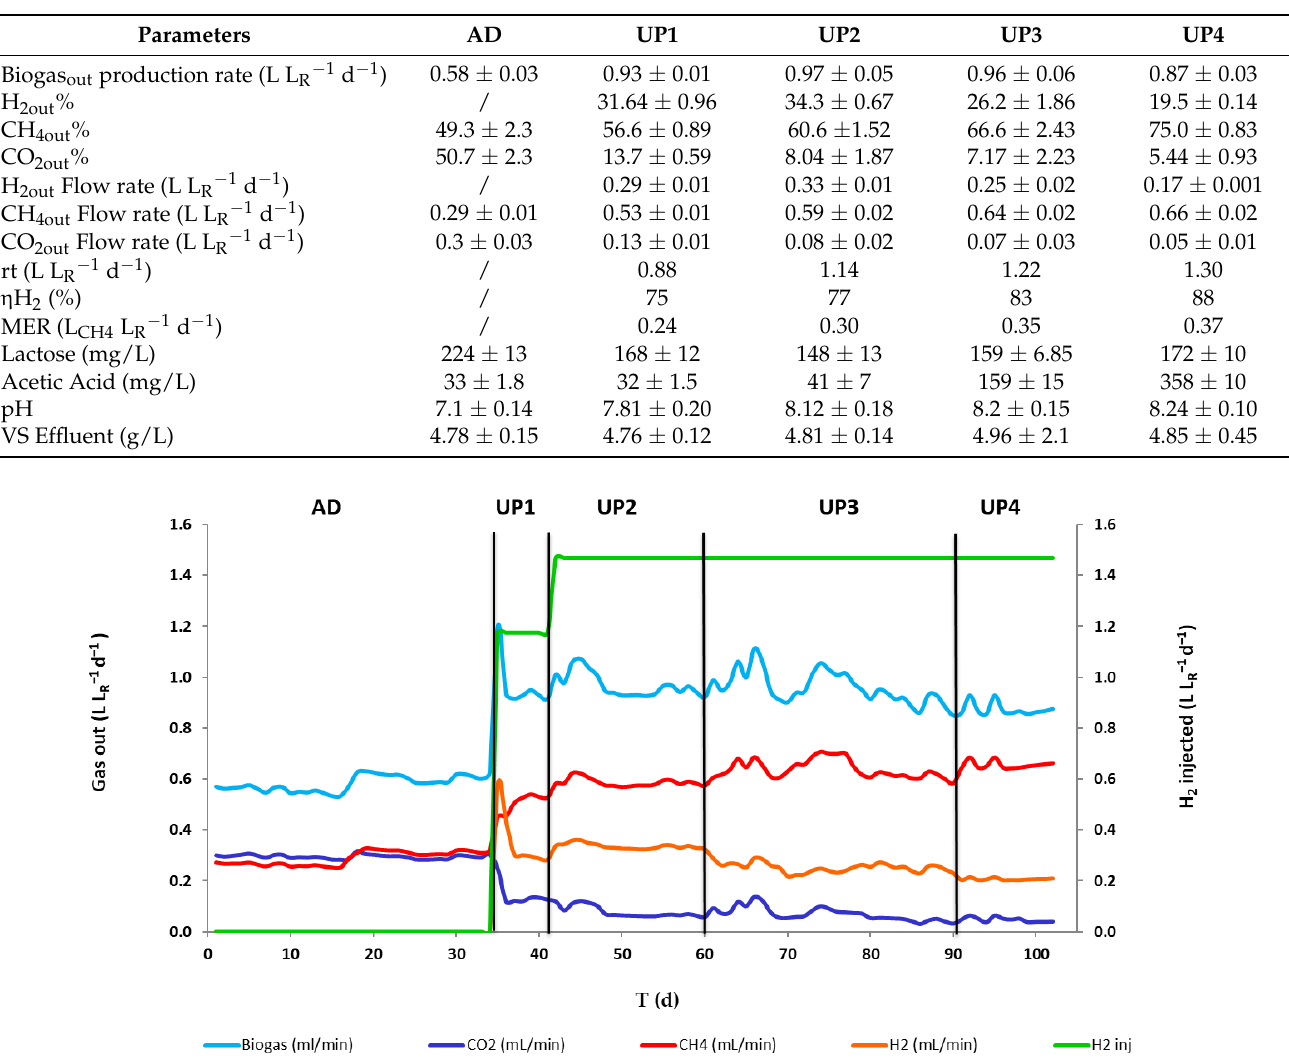
Figure 1. Daily time courses of biogas H 2 , CH 4 , CO 2 flow rates of all experimental phases. After 17 days of the AD period, a consistent rate of methane production was achieved, with an average of 0.29 ± 0.03 L CH4 L R − 1 d − 1 , Figure 1. The pH of the reactor remained stable at around 7.10 ± 0.14, indicating that the system had a strong buffering capacity, even without any pH control being applied. The biogas produced had an average methane content of 49.3 ± 2.3%, as summarized in Table